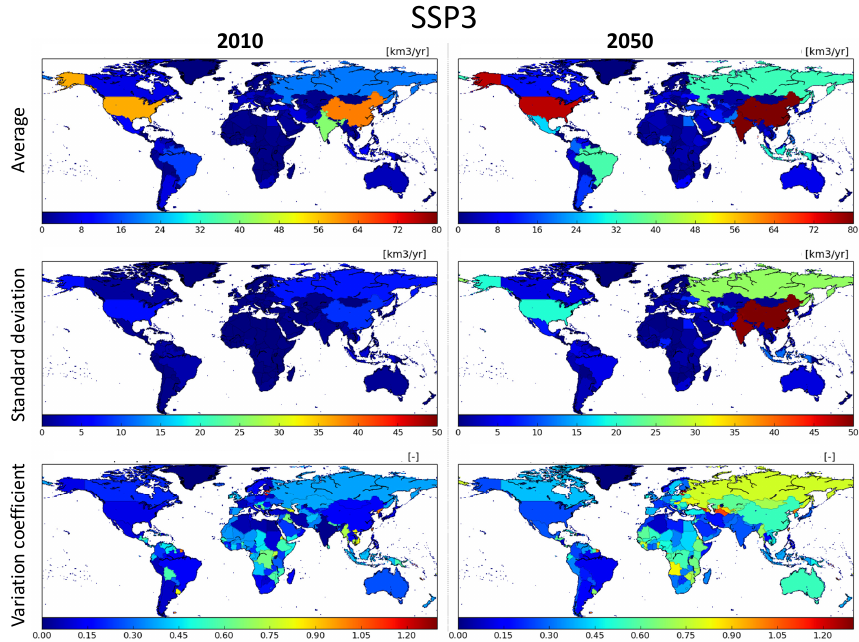
Figure A4. Global maps of projected domestic water withdrawals calculated by the global water models H08, PCR-GLOBWB, and Wa- terGAP for the years 2010 and 2050, respectively, under the SSP3 scenario. Avr, Std, and Std/Avr denote average, standard deviation, and coefficient of variations